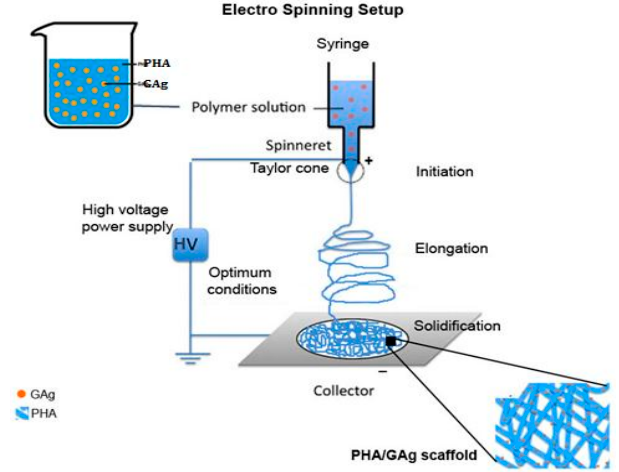
Figure 4. Schematic diagram of electro spinning PHA/GAg scaffold.